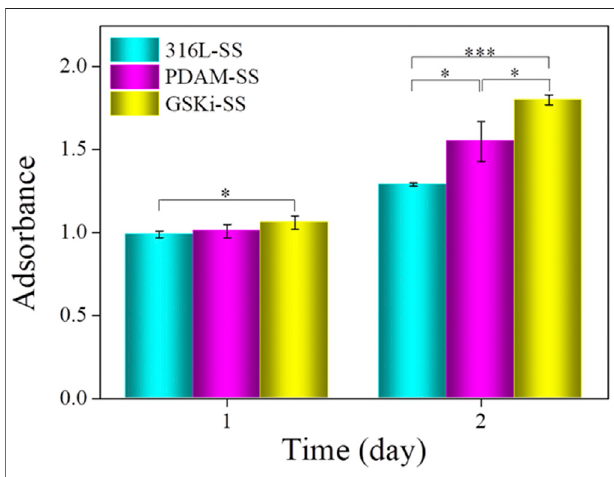
FIGURE 9 | Fluorescence images of HCAECs cultured on different samples for 2 and 24 h; the scale bar is 200 μ m.